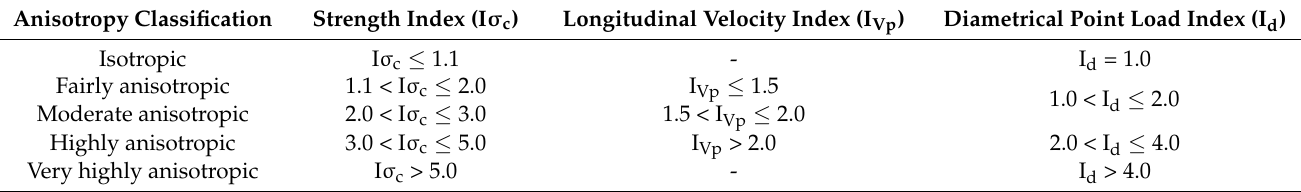
Table 9. Suggested classes for the classification of anisotropic rocks